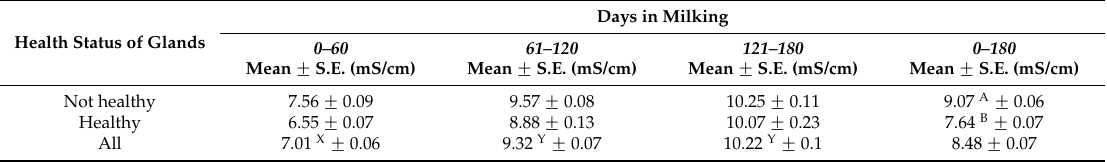
Table 8. Overall means and standard errors (S.E.) of electrical conductivity (mS/cm) of gland milk samples according to mammary gland health status and lactation